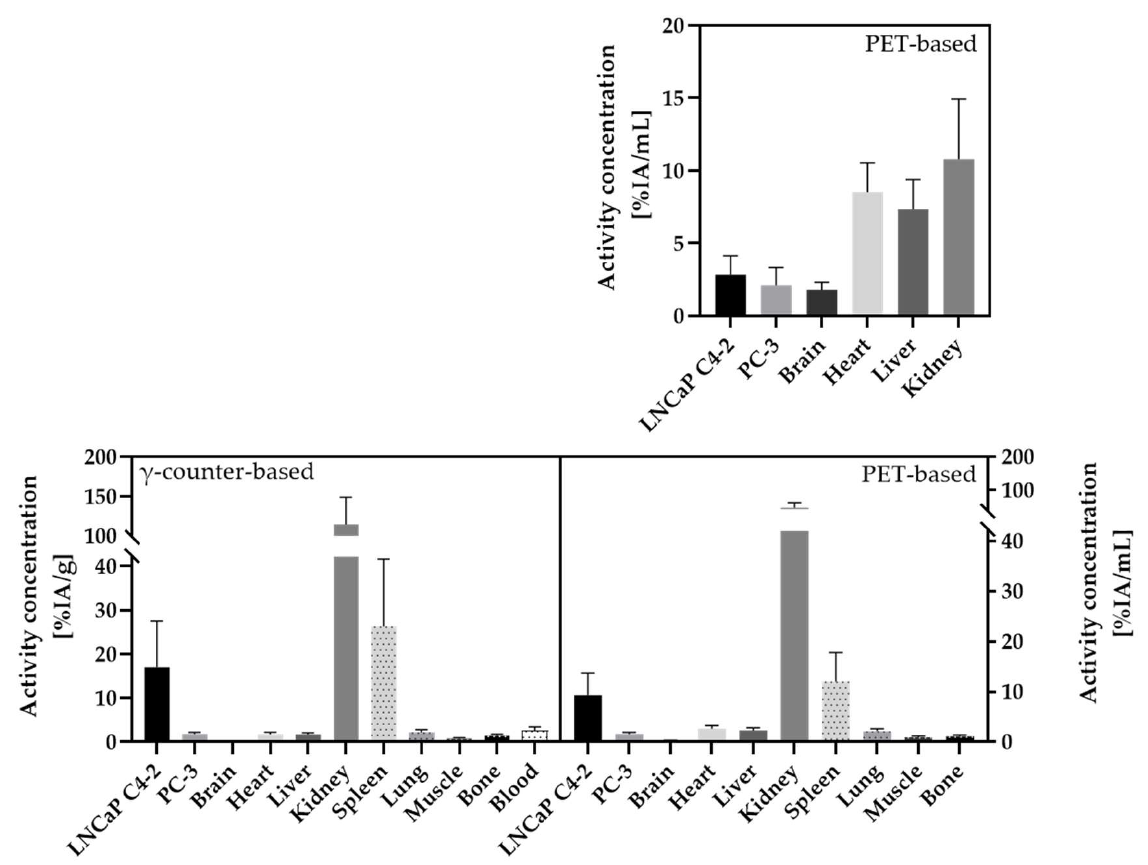
Figure 8. Biodistribution of [ 18 F]F-siPSMA-14 in organs of interest, based on PET evaluations in the HET-CAM model ( top row ) and PET and γ -counter evaluation in the mouse model ( bottom row ), respectively. In both models, as described previously, a significantly higher uptake of [ 18 F]F-siPSMA-14 was detected in the PSMA + tumor LNCaP C4-2 compared with the PSMA − tumor PC-3. The highest activity concentration was detected in kidneys in both models, or evaluation approaches. In the mouse, a high activity concentration was additionally detected in the spleen. In both in vivo models, accumulation in the brain was minimal. Low signal was also detected in the heart, lung, muscle, and bone in the mouse with both evaluation methods, whereas based on the PET data in the HET-CAM, activity concentrations were raised in the heart and